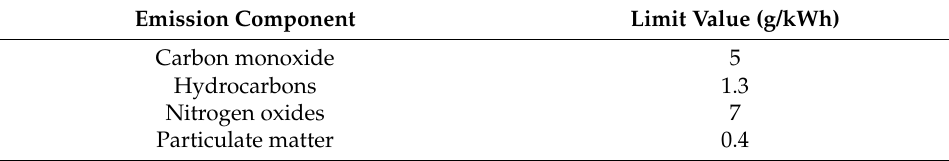
Table 3. Tier II Emission limits for nonroad engines (results of the standardized nonroad steady cycle according to ISO 8178-4—type C1).